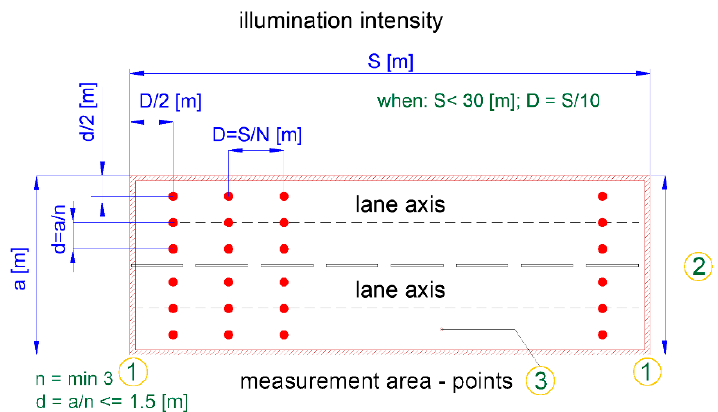
Figure 2. Measuring points on the surface under consideration. Where: 1—luminaire, 2—width of the considered surface Wr, 3—design area. Markings according to the standard [40].